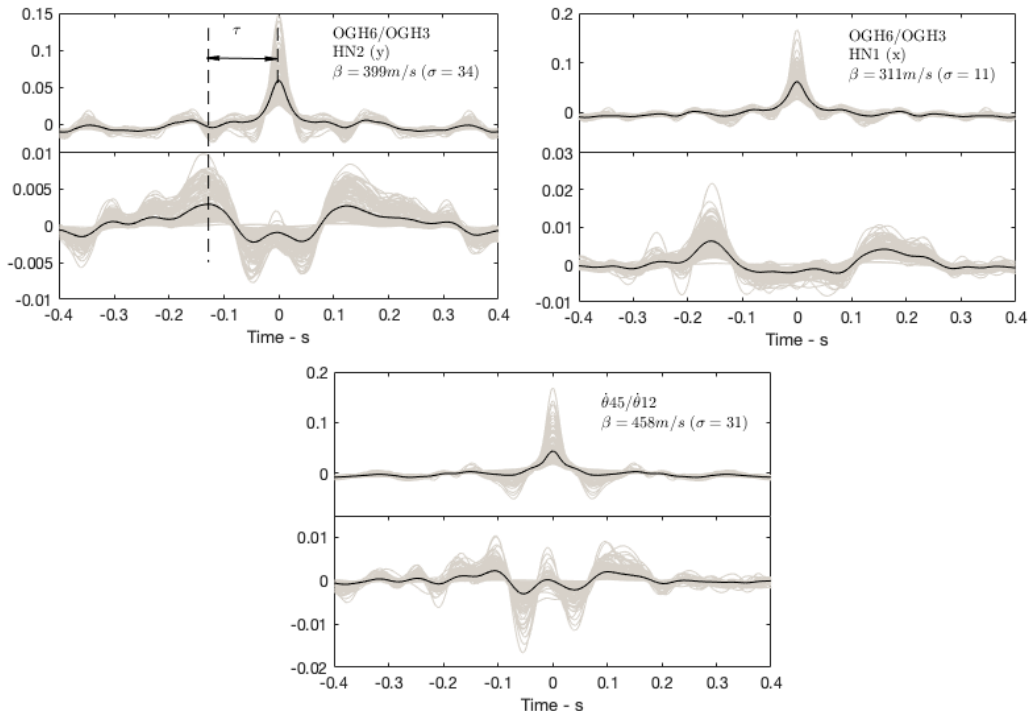
Figure 10. Interferograms obtained by seismic interferometry by deconvolution (SIbyD) between the horizontal components of sensors OGH6 and OGH3 in directions x and y, and with the array-derived rotation rates at the top 𝜃(cid:4662) (cid:2872)(cid:2873) and at the bottom 𝜃(cid:4662) (cid:2869)(cid:2870) of the structure.